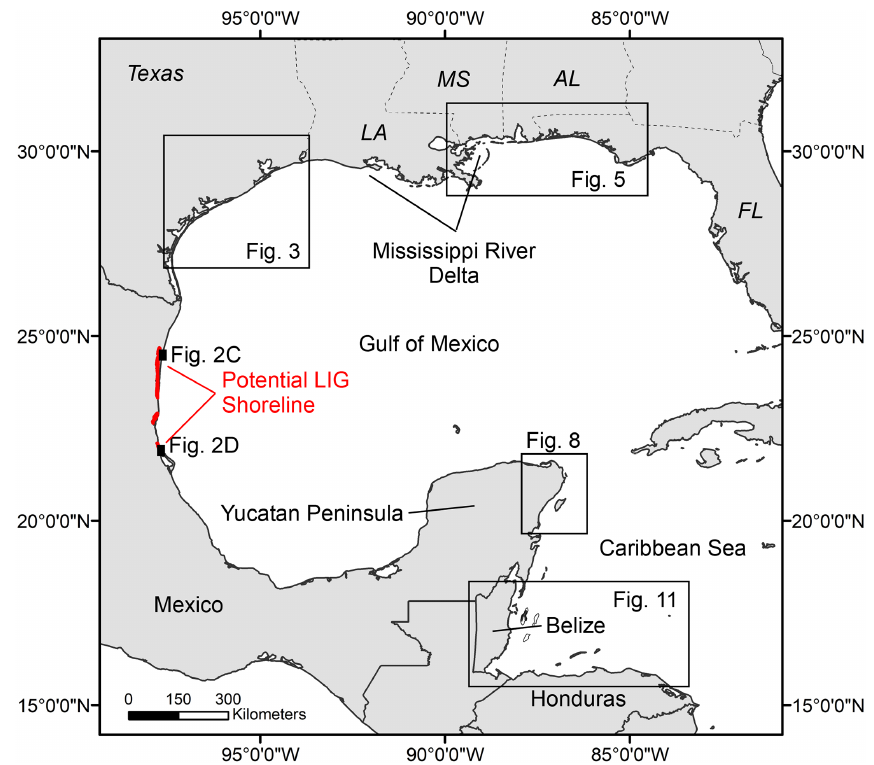
Figure 1. Map illustrating the location of the figures and locations mentioned in the text. LA: Louisiana; MS: Mississippi; AL: Alabama; FL: